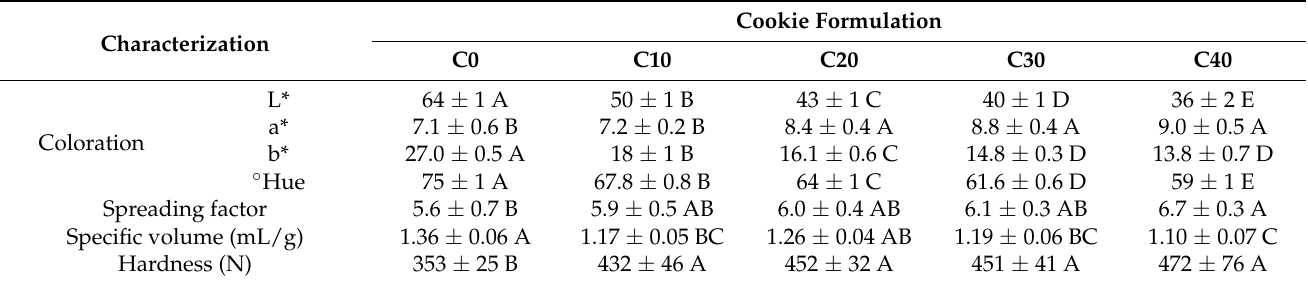
Table 3. Physical properties of the cookies produced.